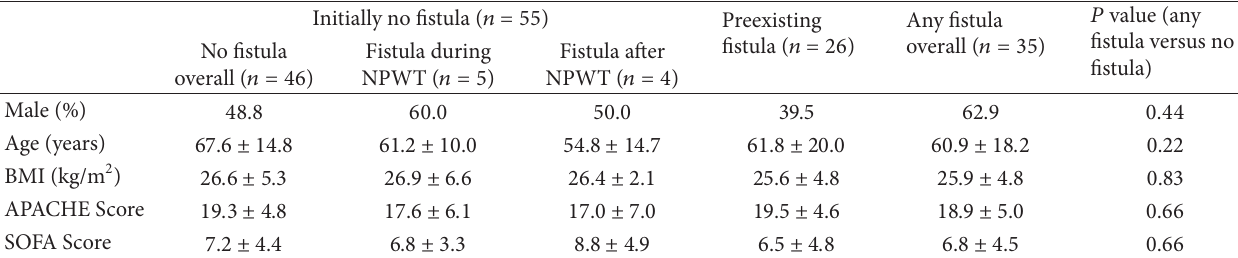
Table 1: Patient demographics.